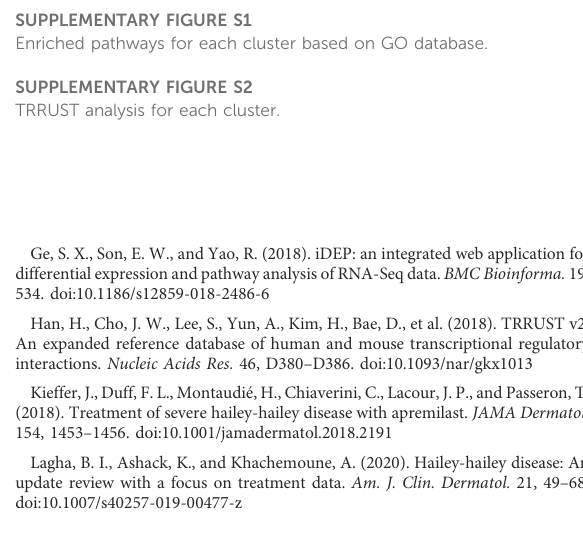
SUPPLEMENTARY FIGURE S1 Enriched pathways for each cluster based on GO database. SUPPLEMENTARY FIGURE S2 TRRUST analysis for each